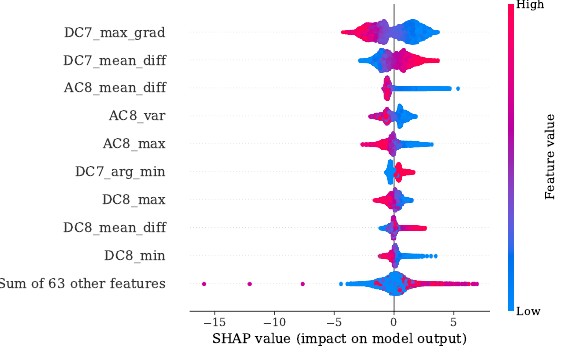
Figure 22. SHAP values summary of MFB50 regression with regard to training set of engine 1.